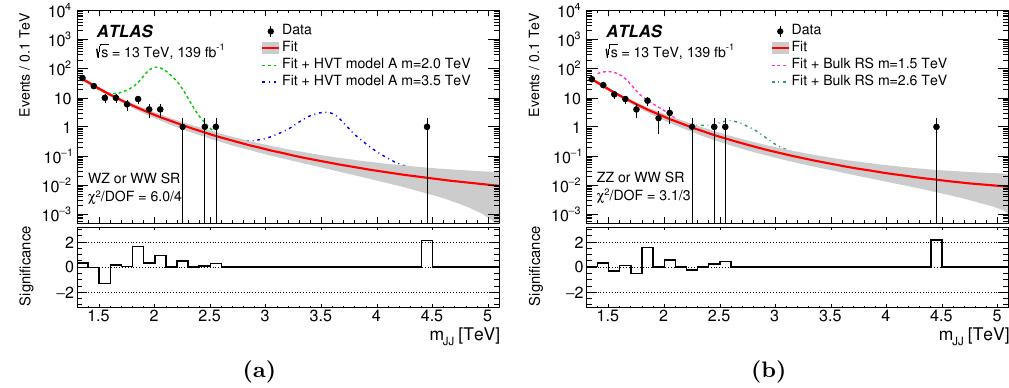
Figure 8 . Background-only (cid:12)ts to the dijet mass ( m ) distributions in data after tagging in JJ the combined (a) WW + WZ , and (b) WW + ZZ signal region. The shaded bands represent the uncertainty in the background expectation calculated from the maximum-likelihood function. The lower panels show the signi(cid:12)cance, de(cid:12)ned as the z -value as described in ref. [68]. Selected theoretical signal distributions are overlaid on top of the background.